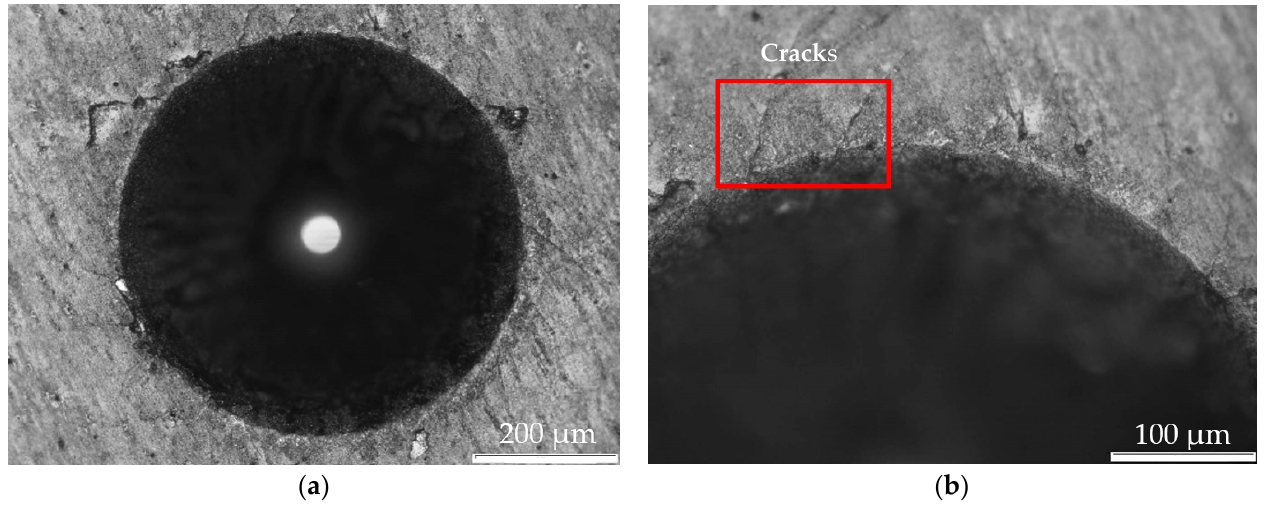
Figure 5. Indentation performed on the surface of the coatings using an optical microscope: ( a ) magnification of ×100, ( b ) a magnification ×200.